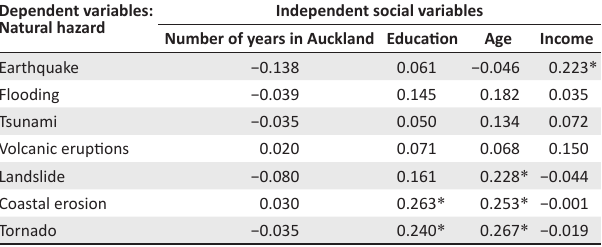
TABLE 9: Summary of correlation between social variables and hazard